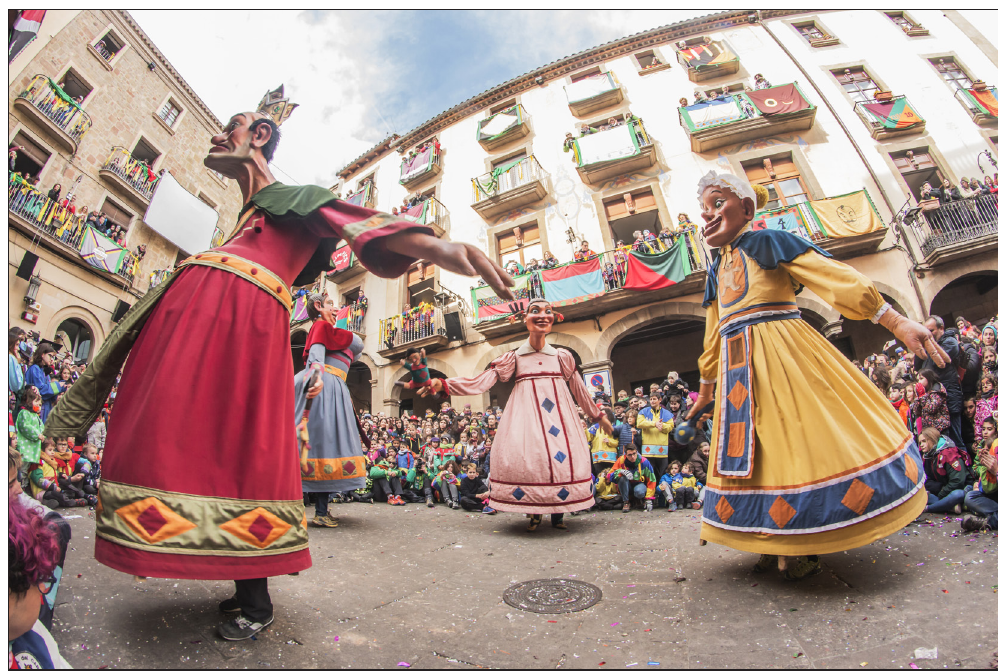
Figure 3: The dance of the Giants ( els Gegants ) in the Main Square ( Plaça Major ) – one of the many performances of the Carnaval . (Photo: Victor Pisa, courtesy of the Associació de Festes del Carneval de Solsona, Solsona